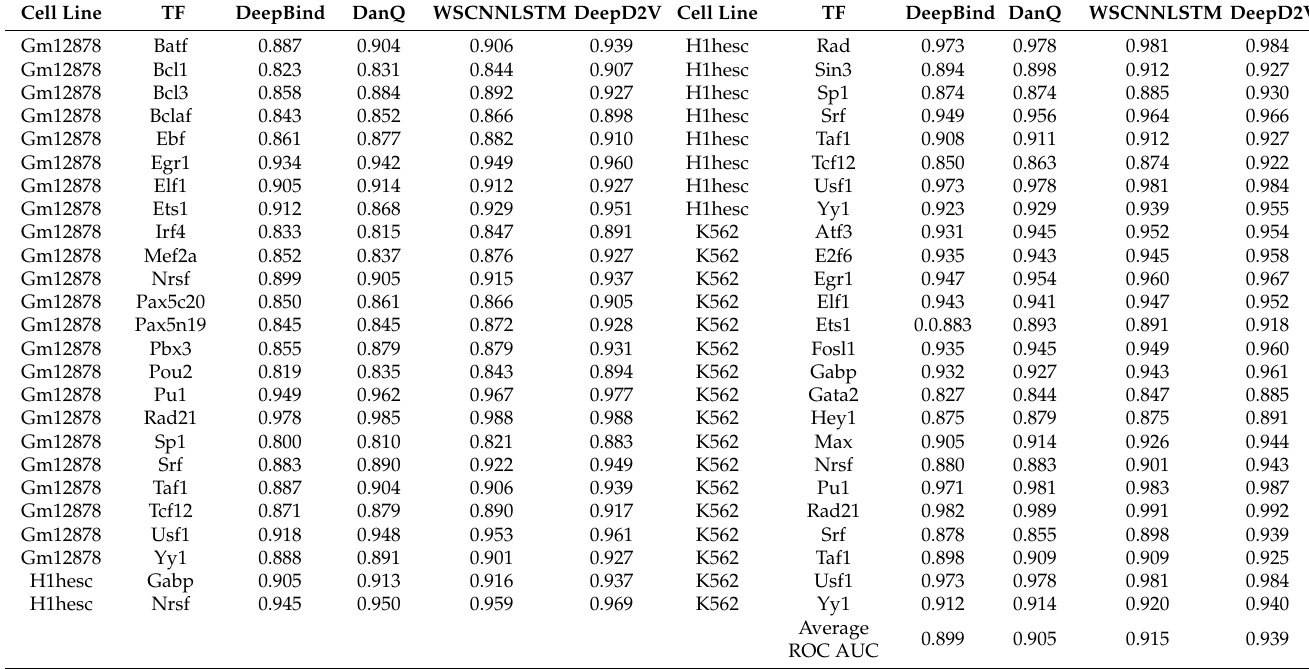
Figure 9. Comparison of DeepD2V and the competing methods on 50 ChIP-seq in-vivo data under the ROC AUC, PR AUC and F1-score metrics. Table 2. AUC performance metric of DeepD2V with other deep learning